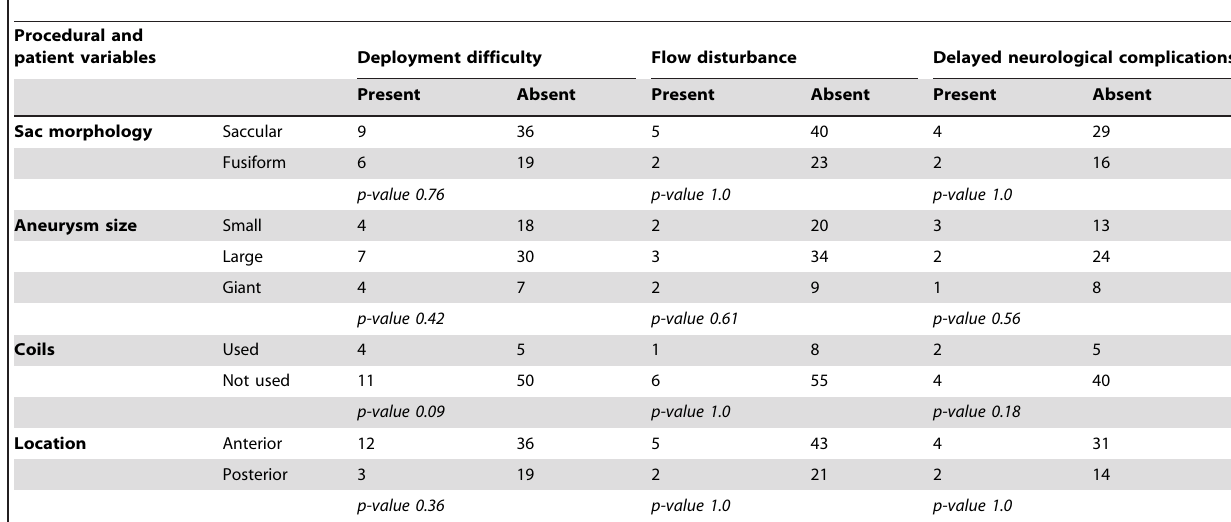
Table 4. Effect of patient and procedure related variables on SFD deployment difficulty, flow disturbance, and delayed neurological